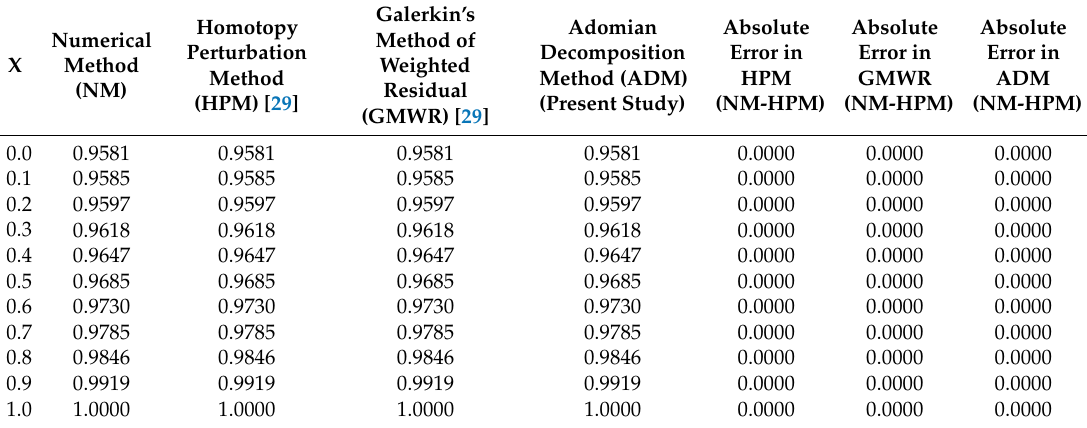
Table 1. Comparison of temperature